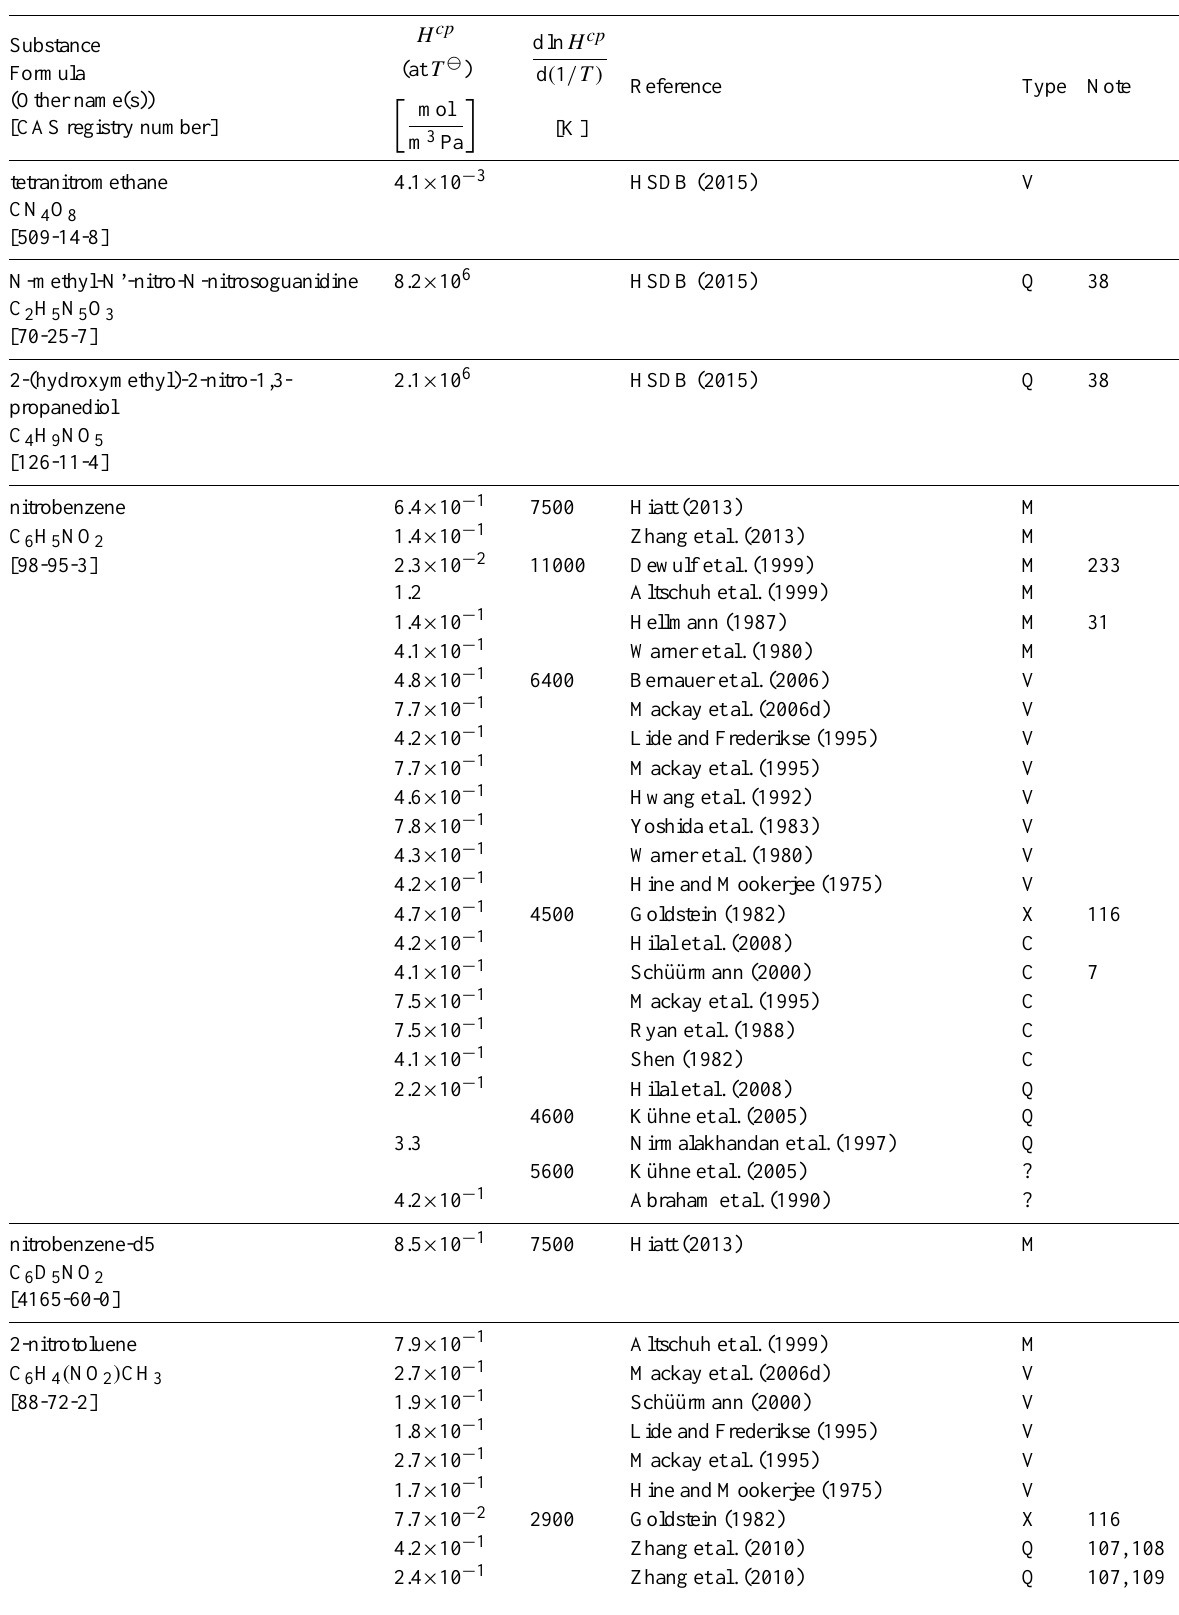
Table 6: Henry’s law constants for water as solvent